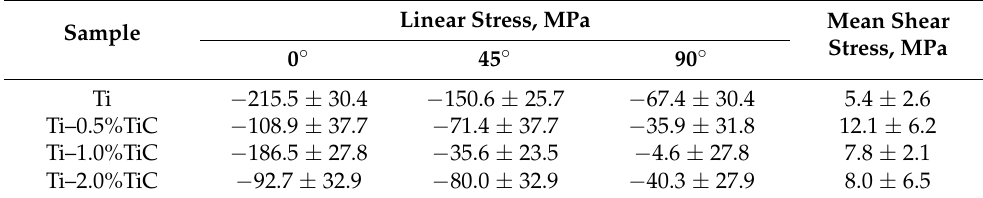
Figure 13. Examples of residual stress diagrams obtained for Ti and Ti–TiC sinters. Table 5. Residual stress values depending of sample orientation ( ϕ